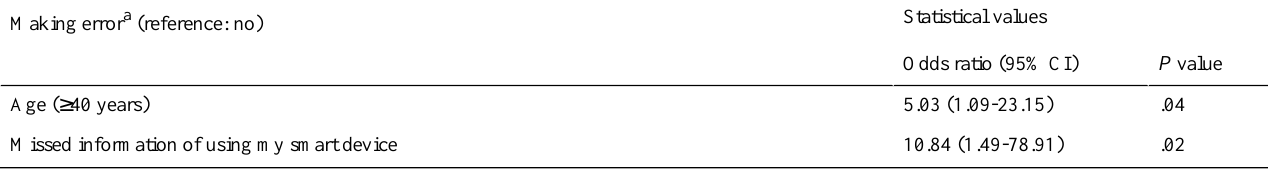
Table 11. Stepwise multivariate logistic regression of predictors of making error. Variables included in the stepwise regression model were with the following covariates: age (reference: <30 years); gender (reference: female); job (reference: medical student); missed information of using my smart device; used for personal purposes during your shift in the emergency department; addiction